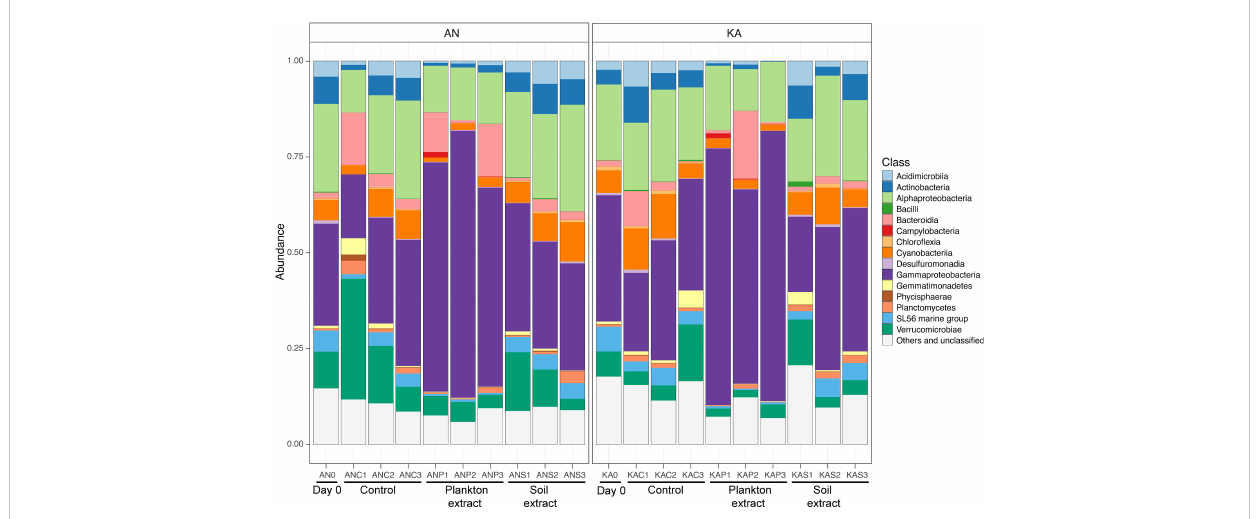
FIGURE 5 Relative abundance of major bacterial taxa at the class level at the start (day 0, before amendments) and end (day 2) of the experiment, in Kalvarsskatan (KA) and Ängerån (AN). AN0 indicates the start sample in Ängerån, and ANC1, ANC2, and ANC3 indicate triplicate samples of the control taken on day 2 in Ängerån. ANP1, ANP2, and ANP3 indicate triplicate samples of the plankton extract treatment taken on day 2 in Ängerån, and ANS1, ANS2, and ANS3 indicate triplicate samples of the soil extract treatment taken on day 2 in Ängerån. KA0 indicates the start sample in Kalvarsskatan, and KAC1, KAC2, and KAC3 indicate triplicate samples of the control taken on day 2 in Kalvarsskatan. KAP1, KAP2, and KAP3 indicate triplicate samples of the plankton extract treatment taken on day 2 in Kalvarsskatan, and KAS1, KAS2, and KAS3 indicate triplicate samples of the soil